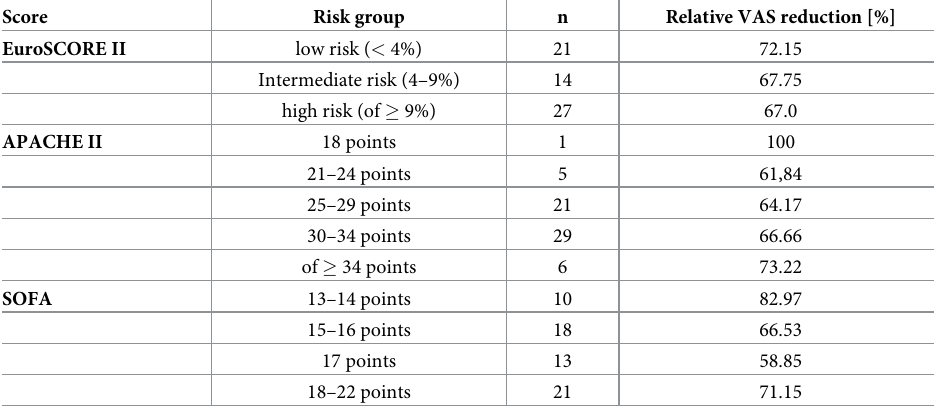
Table 3. Relative vasoactive score (VAS)